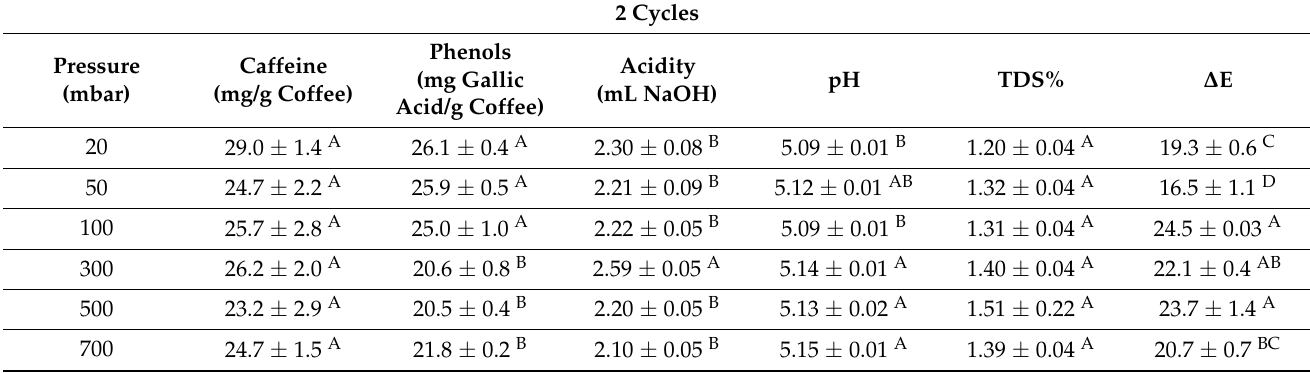
Table 4. Effect of pressure on physicochemical properties for 2 vacuum cycles (avg ± SD, n = 3) 1,2 . 2